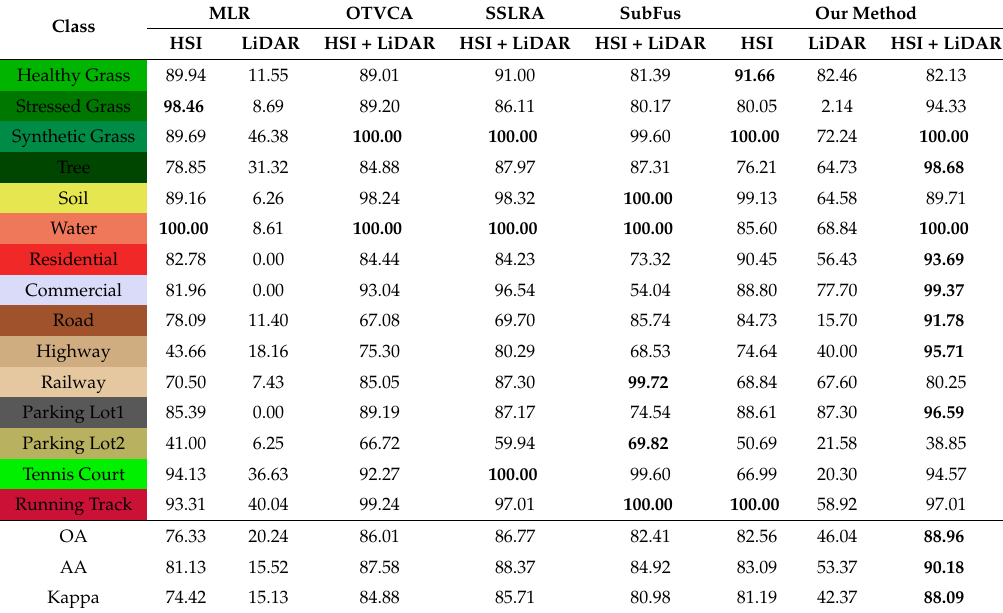
Table 4. Classification accuracies of all considered techniques on Houston 2013 dataset.